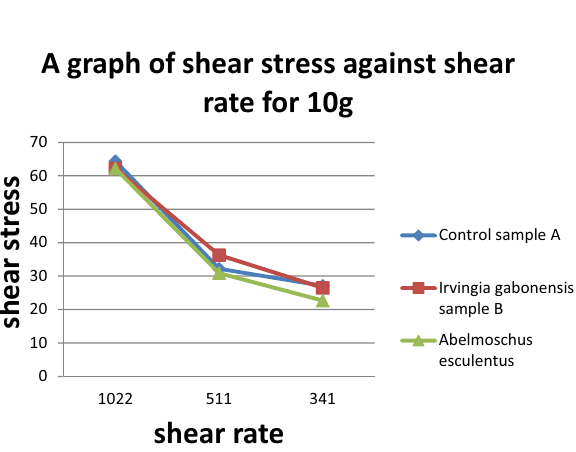
Fig. 7 Graph of shear stress against shear rate for 8 gram